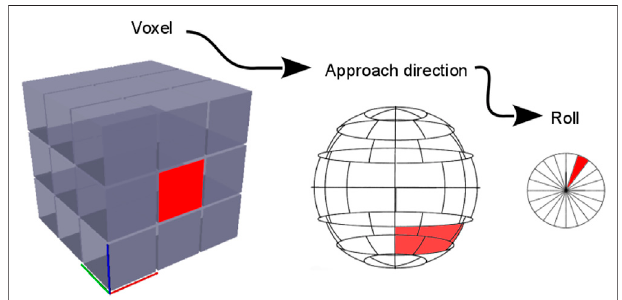
FIGURE 1 | Hierarchical discretization of the end-effector pose ξ for ef fi cient generation ofthe reachability map. The Cartesian spaceis discretized with voxels. Each voxel has an associated virtual sphere that discretizes the possible approach directions (pitch and yaw). Each surface bin in this virtual sphere has in turn an associated discretization for the roll direction.